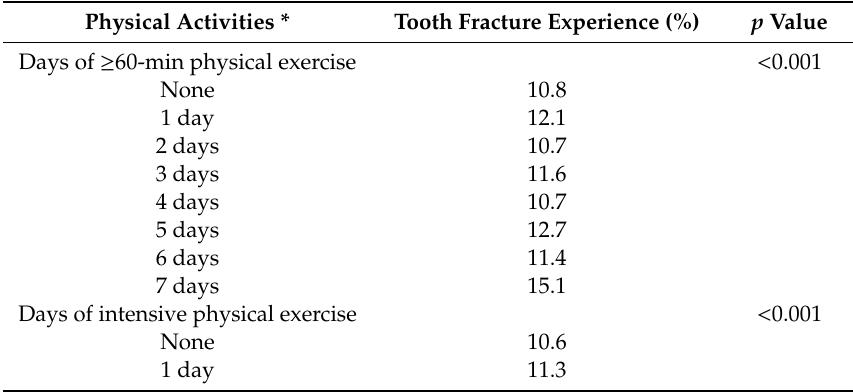
Table 4. Tooth fracture experience related to physical